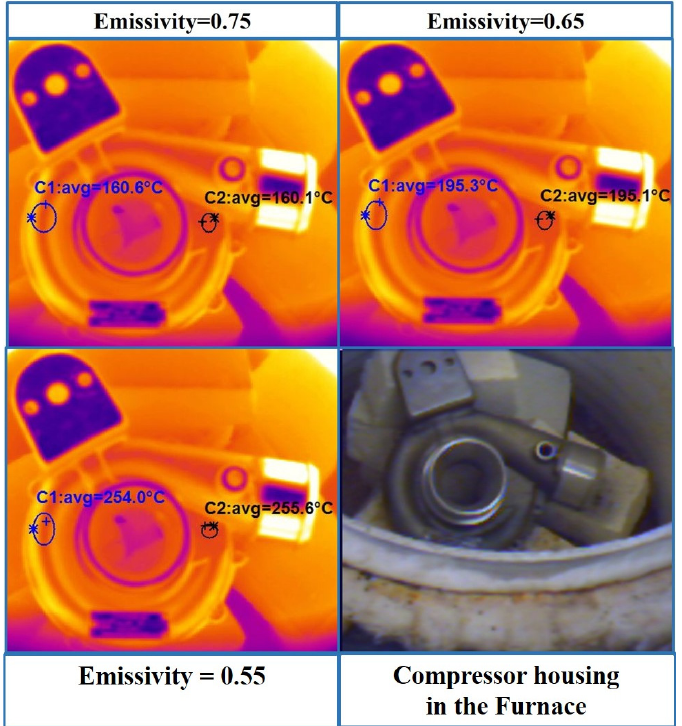
Figure 2. Thermal images of compressor housing for several emissivities, and compressor housing of the furnace (picture at lower right).